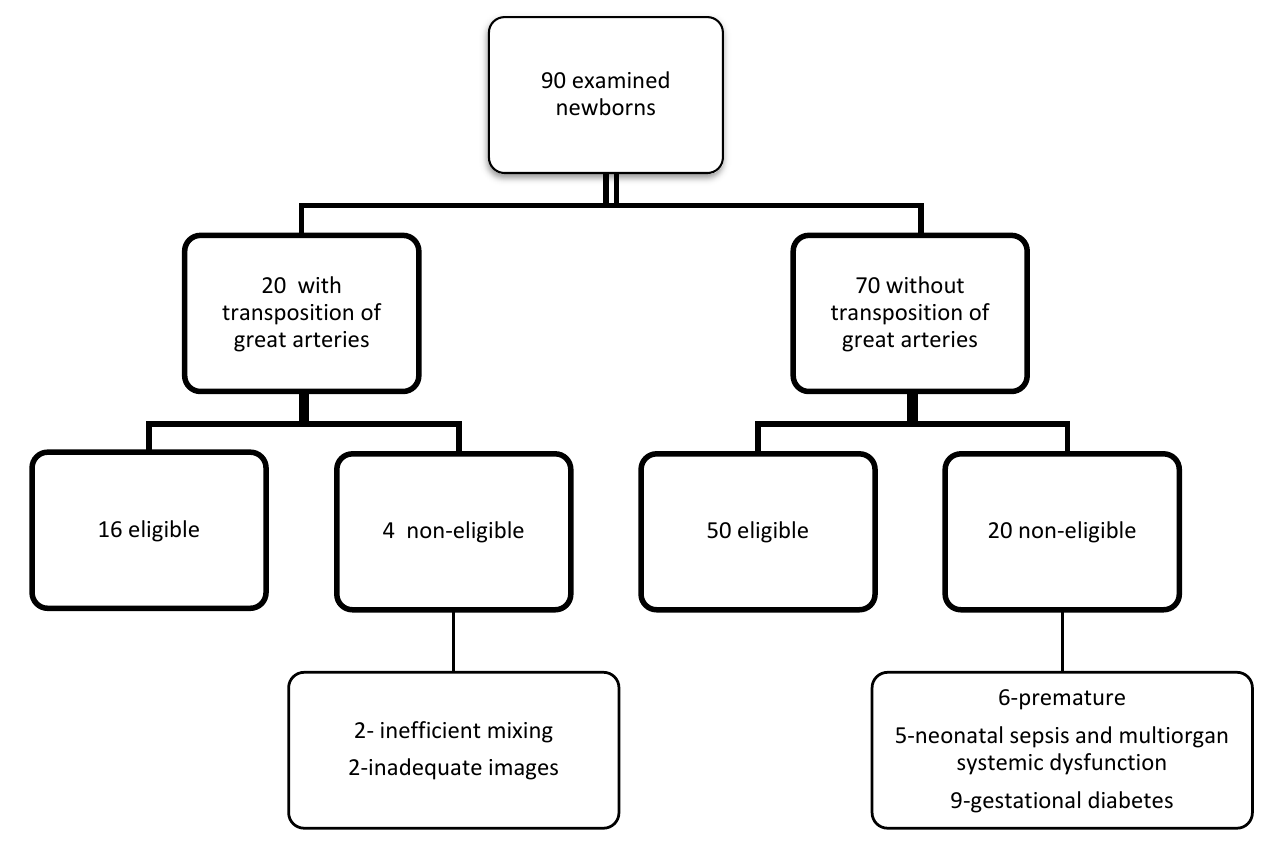
Figure 1. Study Figure 1. Study flowchart.